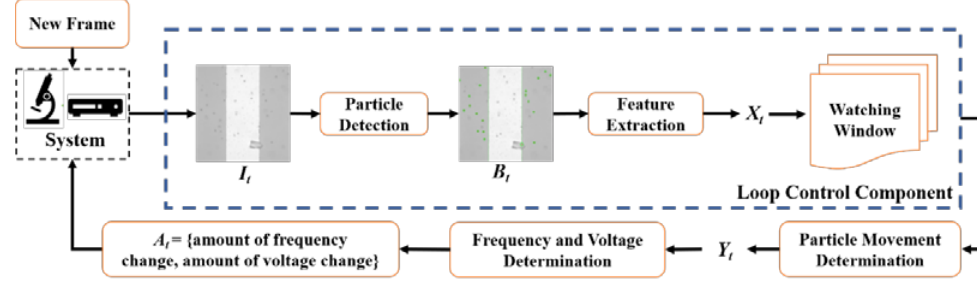
Figure 3. Architecture of the Feedback Control System Design.